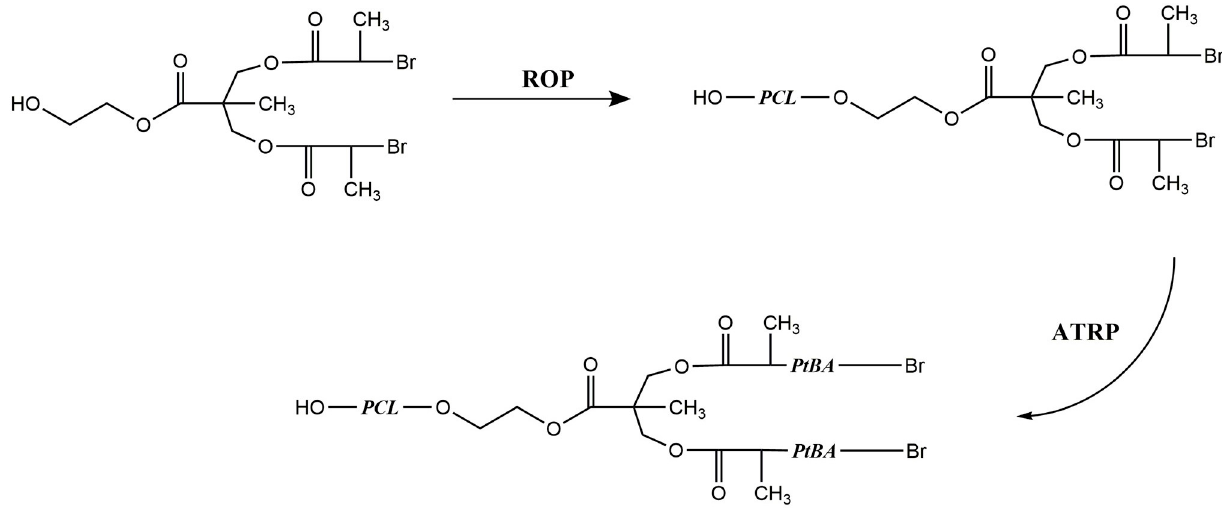
Figure 8. Schematic synthesis of A 2 B-type star polymers based on PCL-PtBA.